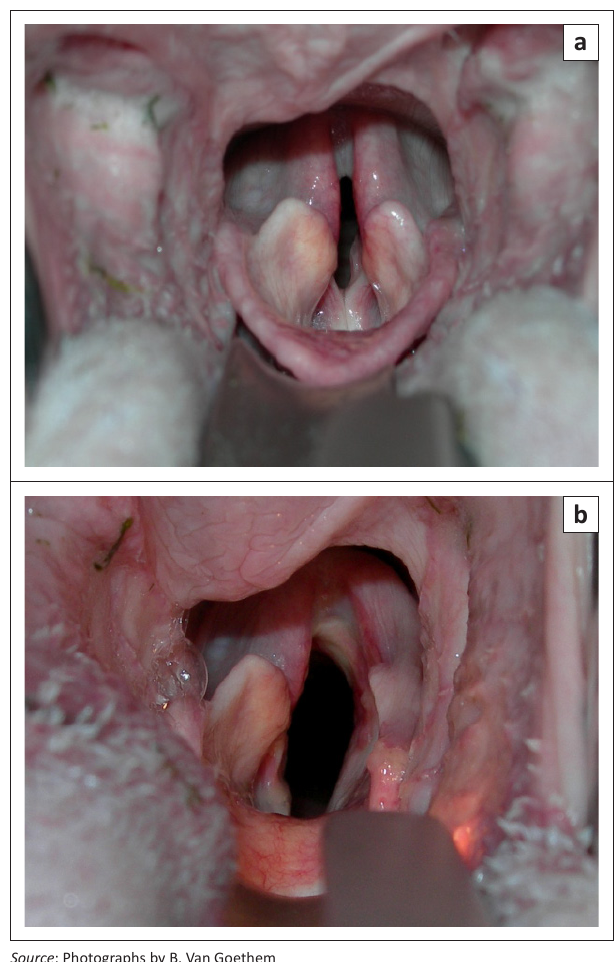
FIGURE 4: Laryngeal inspection in a 10-year-old Maltese dog with laryngeal paralysis, depicting, (a) preoperative appearance and (b) left arytenoid abduction after unilateral arytenoid